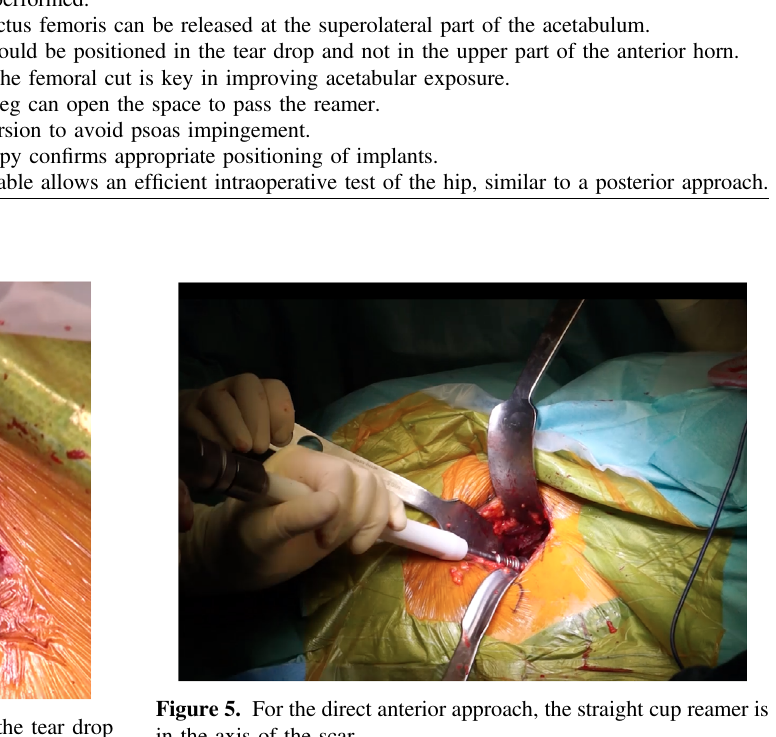
in the axis of the scar.